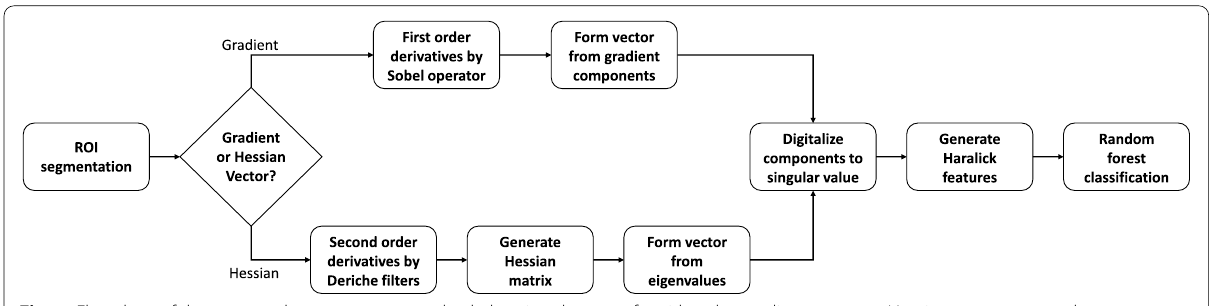
Fig. 1 Flowchart of the proposed vector-texture method, showing the steps for either the gradient vector or Hessian vector approach